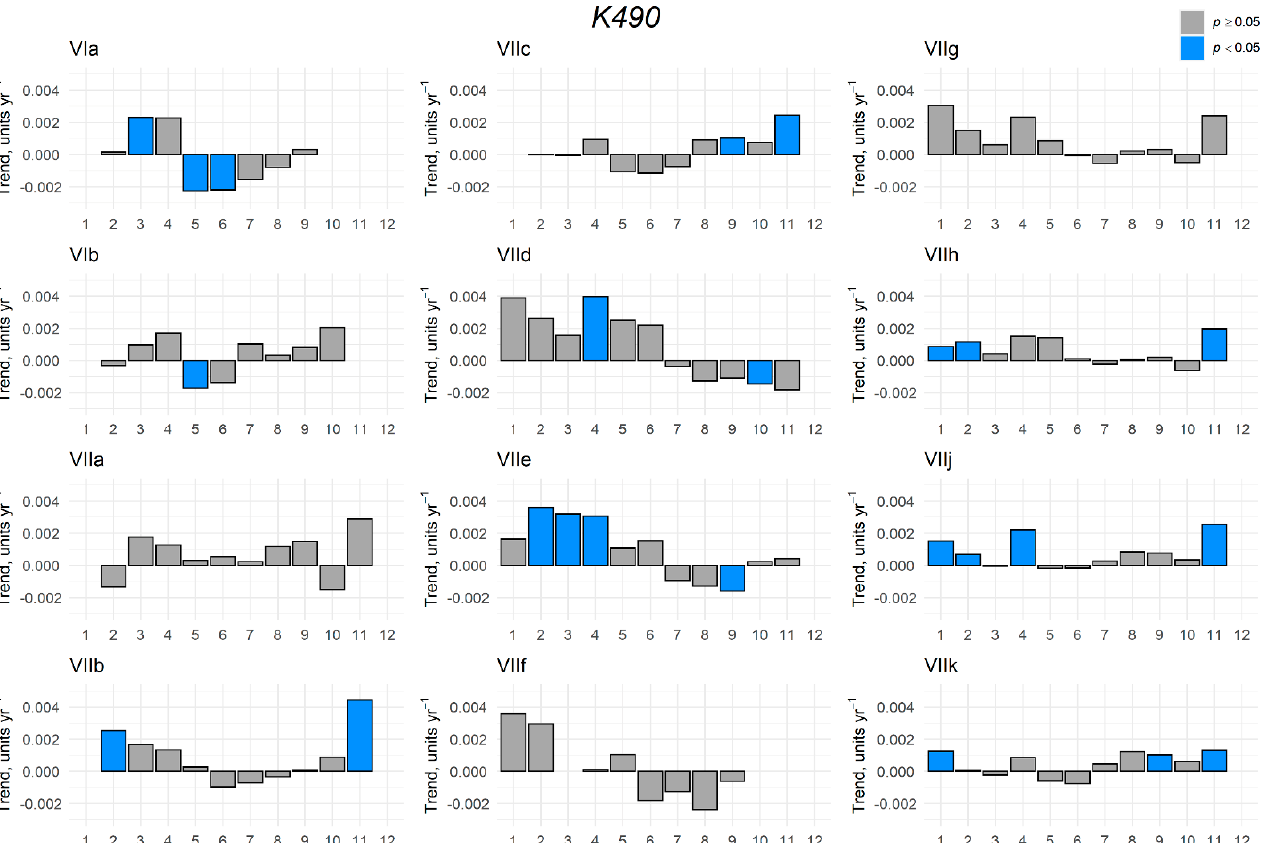
Figure 8. Trends by months for the different ICES divisions. Bar heights measure trend magnitude for each month and the Sen slope over the period 1998-2016. Blue bars are significant trends ( p < 0.05) based on Mann-Kendall test. The bar is omitted if the proportion of missing values in the first and last fifths of the data is less than 0.5.